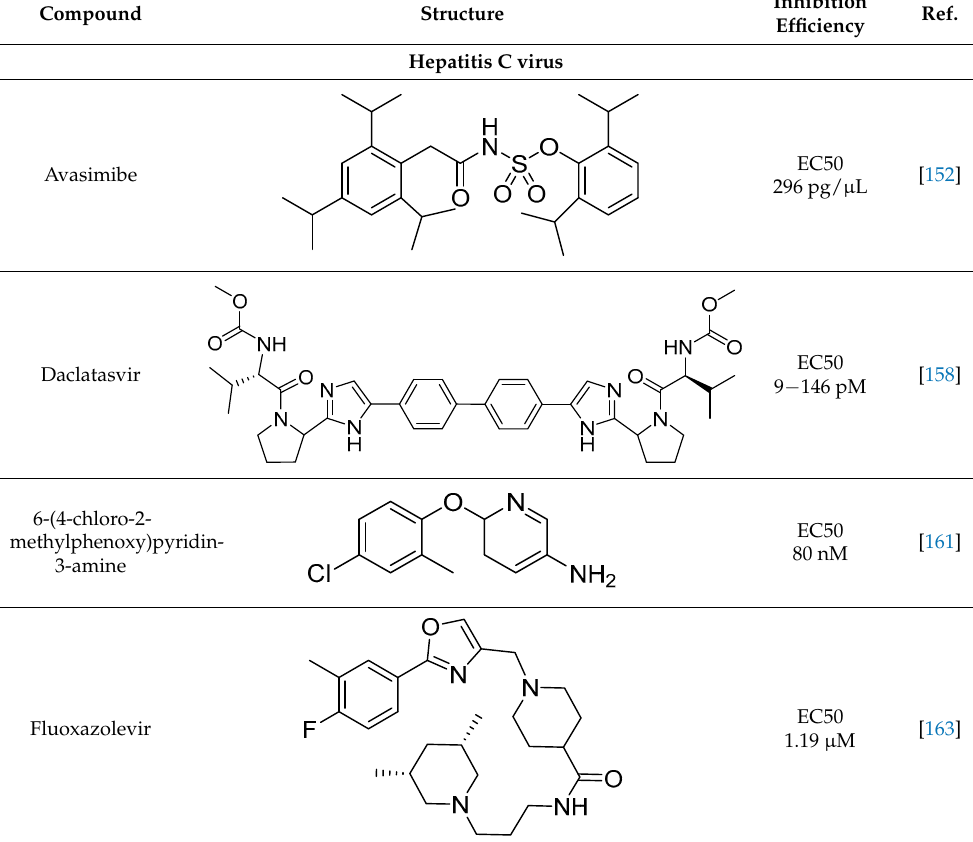
Table 3. List of flavivirus assembly inhibitors. Compound